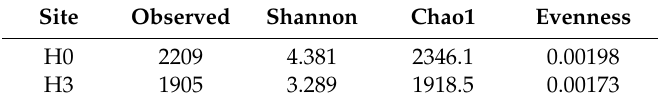
Table 2. Metagenome richness and Alpha diversity indexes, including bacteria, archaea and viral diversity.